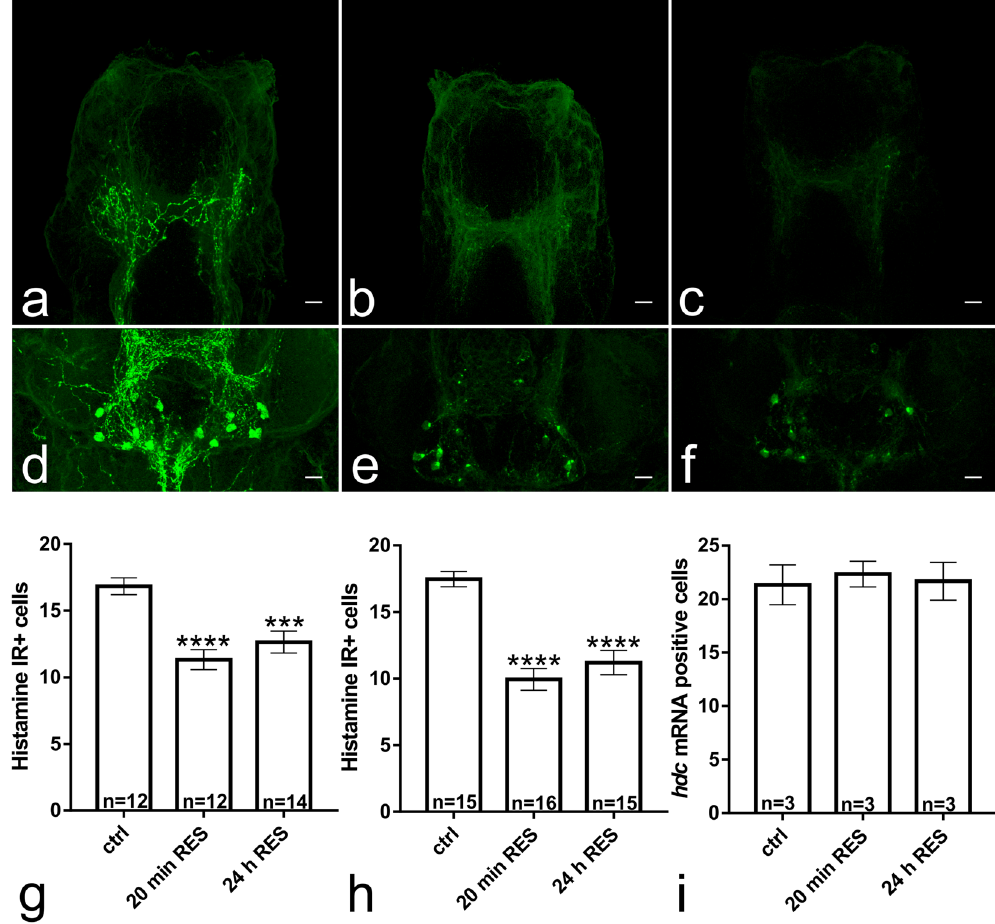
Figure 4. The larvae treated with 40 mg/L reserpine for 20 min ( b ) and 24 h ( c ) showed a clearly diminished number of histamine immunoreactive fibers in the telencephalon compared with controls ( a ) 72 h after administration of reserpine. A similar effect was seen in the hypothalamus, where larvae in the 20 min ( e ) and 24 h ( f ) treated groups had a clearly diminished number of histamine immunoreactive cells in comparison to controls ( d ). Some cell bodies showing clear immunoreactivity were still seen in both treatment groups. The dense network of hypothalamic histamine fibres (as seen in d ) was also not present in the reserpine treated fish ( e , f ). The staining pattern observed was similar at 24 h after administration of reserpine (data not shown). In order to quantify the effect on the cell population, the number of cells showing clear cytoplasmic histamine immunoreactivity was counted at 24 h and 72 h after administration of reserpine ( g , h , respectively). At all time points, the number of cells was significantly decreased by 30–40%. In order to verify that the reduction in histamine immunoreactivity was not due to destruction of histamine neurons, we counted the number of hdc mRNA positive cells in brains collected 72 h after administration of reserpine ( i ). No difference was seen between reserpine treated and control brains, indicating that the histamine neurons were intact. Statistical analyzes were done using 1-way ANOVA ( g , i ), followed by Tukey’s multiple comparison tests, respectively. Data are presented as mean ± SEM. *** p < 0.001, **** p < 0.0001 according to the multiple comparison test, in comparison with the control group. Scale bar 10 µ m. The brains are in a horizontal orientation, with the anteroposterior axis pointing